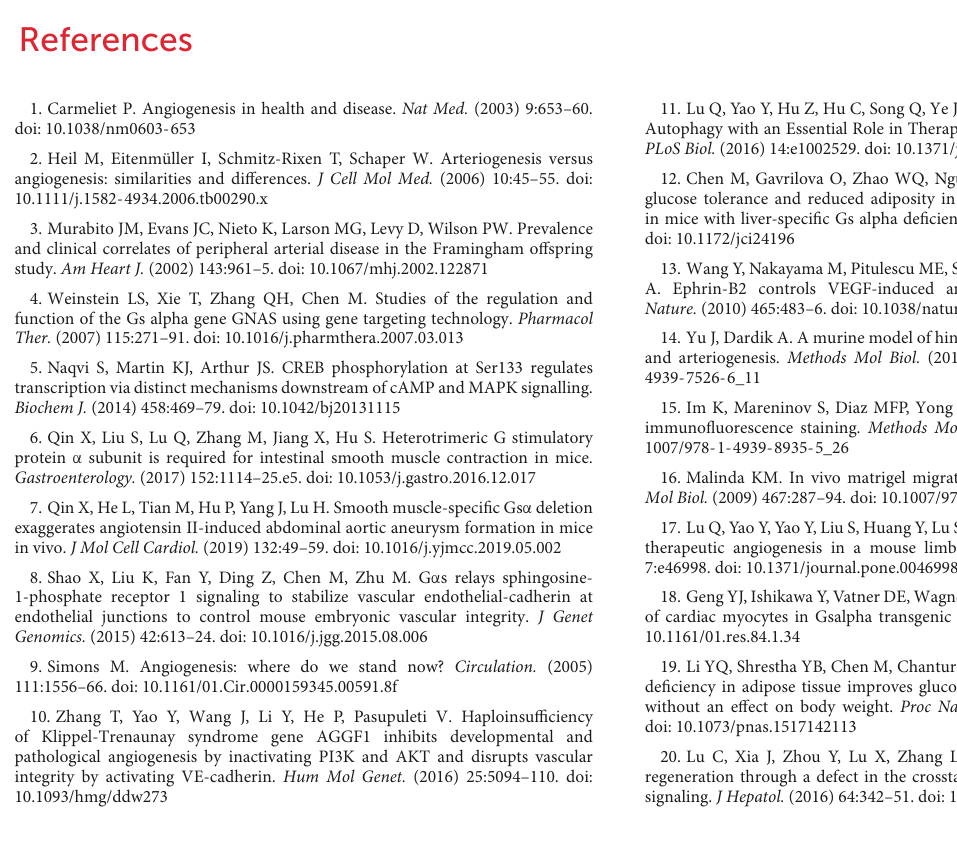
SUPPLEMENTARYFIGURE1 Deletion of Gs α in endothelial cells reduced the expression of AGGF1. (A) Western blot of AGGF1 in isolated lung endothelial cells from CTR and Gs α ECKO mice. (B) Immunofluorescent staining of CD31 (green), AGGF1 (red) and DAPI in ischemic gastrocnemius muscle of CTR and